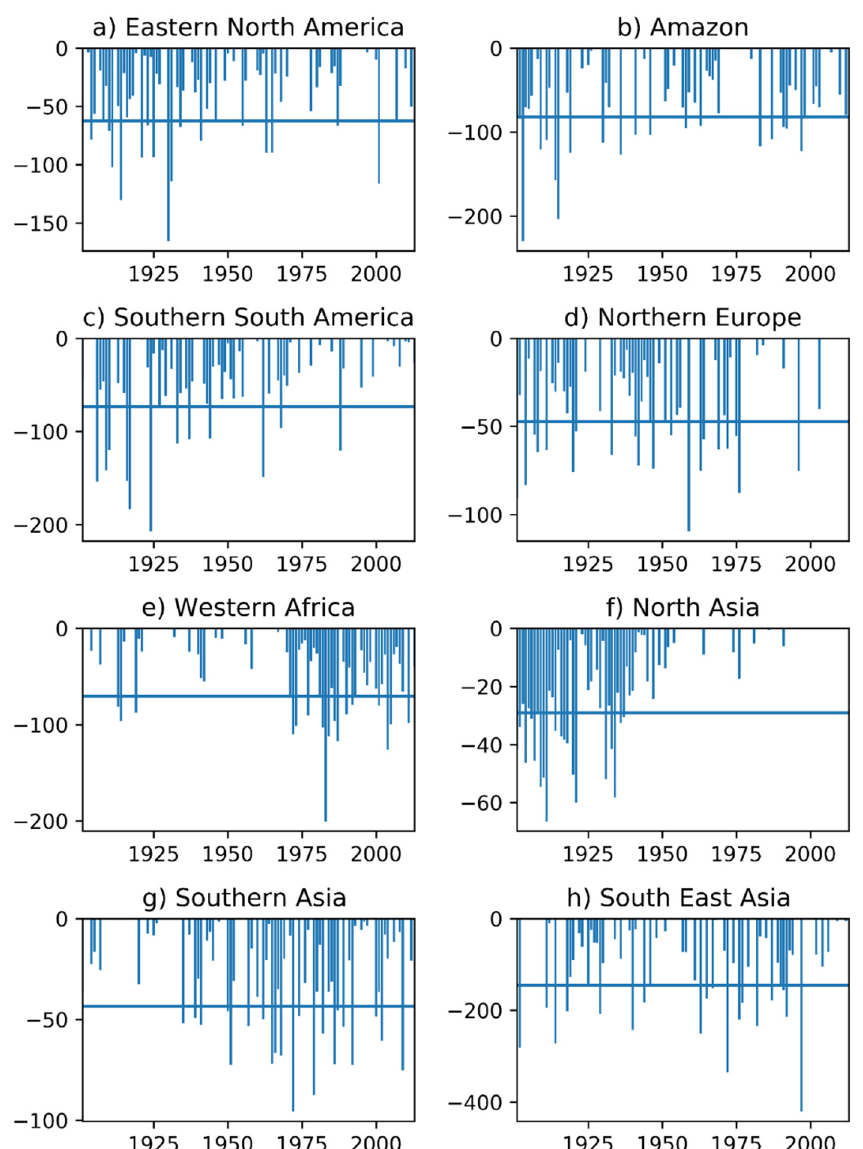
Figure 10. Area average precipitation deficits below the mean and the MSD for the eight LTP regions, 1901–2013. Standard deviations are shown as horizontal lines. Units are mm.